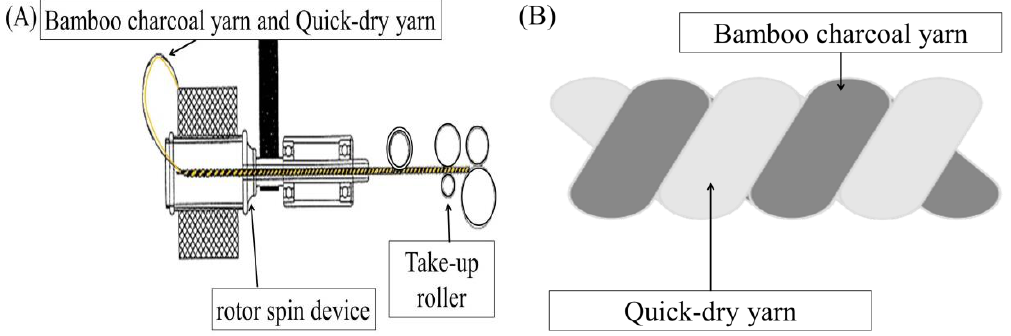
Figure 1. ( A ) The assembly of a rotor spindle machine and ( B ) the structure of a twisted yarns [26].